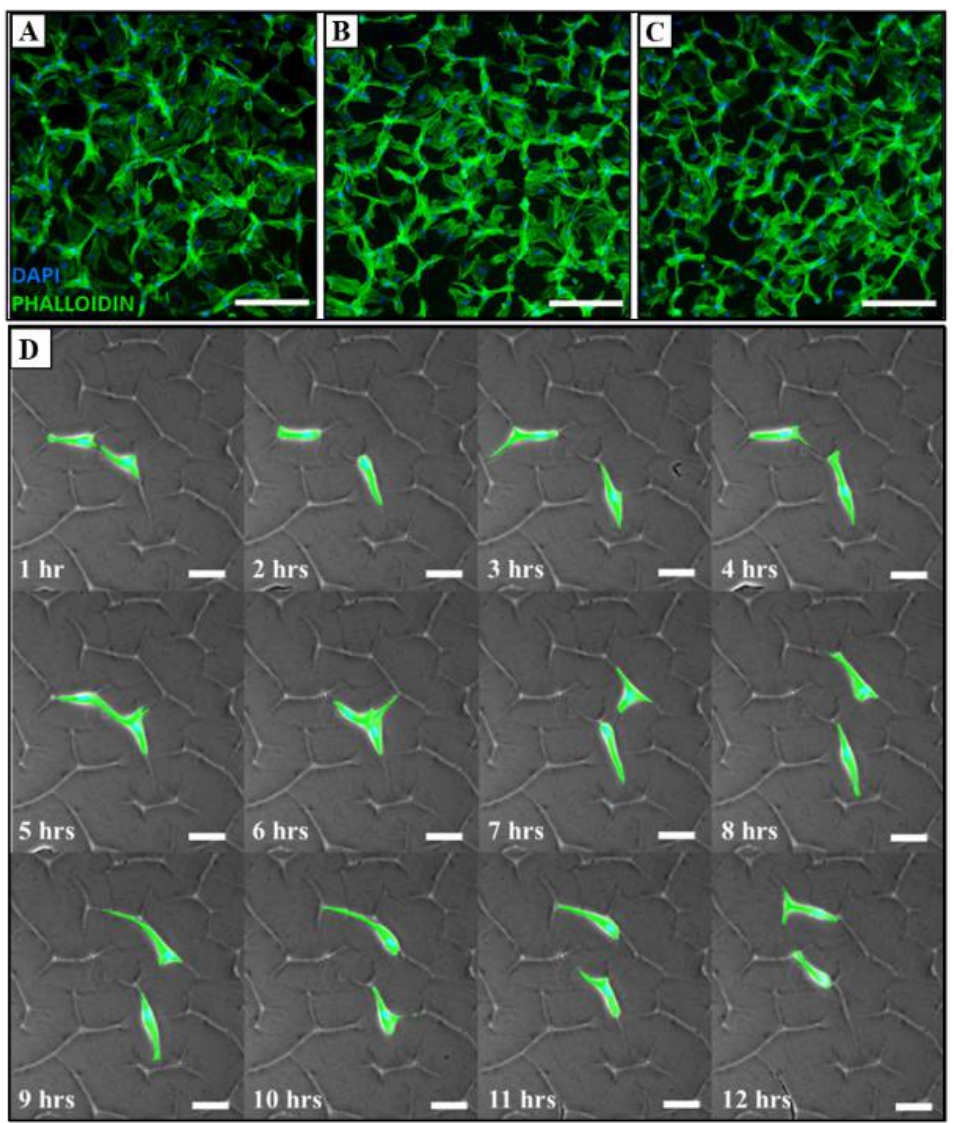
Figure 3. MSCs adhered, spread and migrated along surface topographies. DAPI/phalloidin of MSCs seeded at 5000 cells/cm 2 on AZO-PA hydrogels with ( A ) ~100, ( B ) ~75 and ( C ) ~50 μm gel thickness (scale bar = 250 µm) and ( D ) sequential images from live cell tracking demonstrating MSC migration along surface creases over 12 h for cells seeded at 500 cells/cm 2 (scale bar = 50 µm).